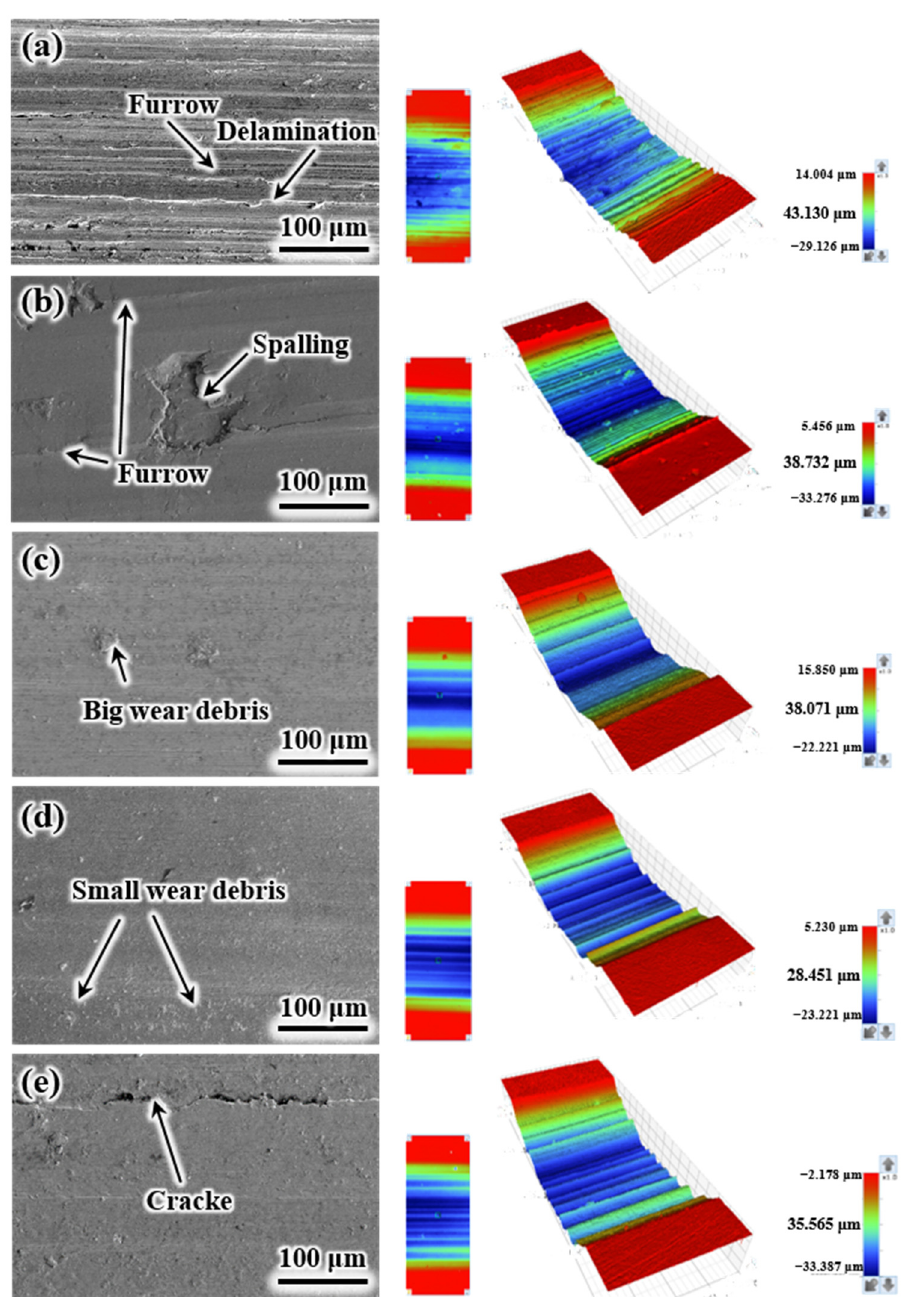
Figure 11. Wear morphologies of the composite coatings and corresponding 3D morphologies of the wear scar of the composite coatings: ( a ) TC4; ( b ) 0 WC; ( c ) 5 WC; ( d ) 10 WC; ( e ) 15 WC.